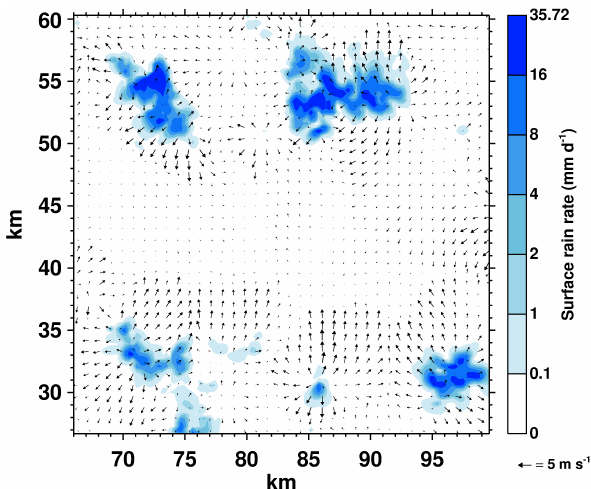
Fig. 8. Surface rain rate and residual horizontal surface wind field after 26h in a select region of simulation S ◦ . The color scale ex- tends to the rain rate